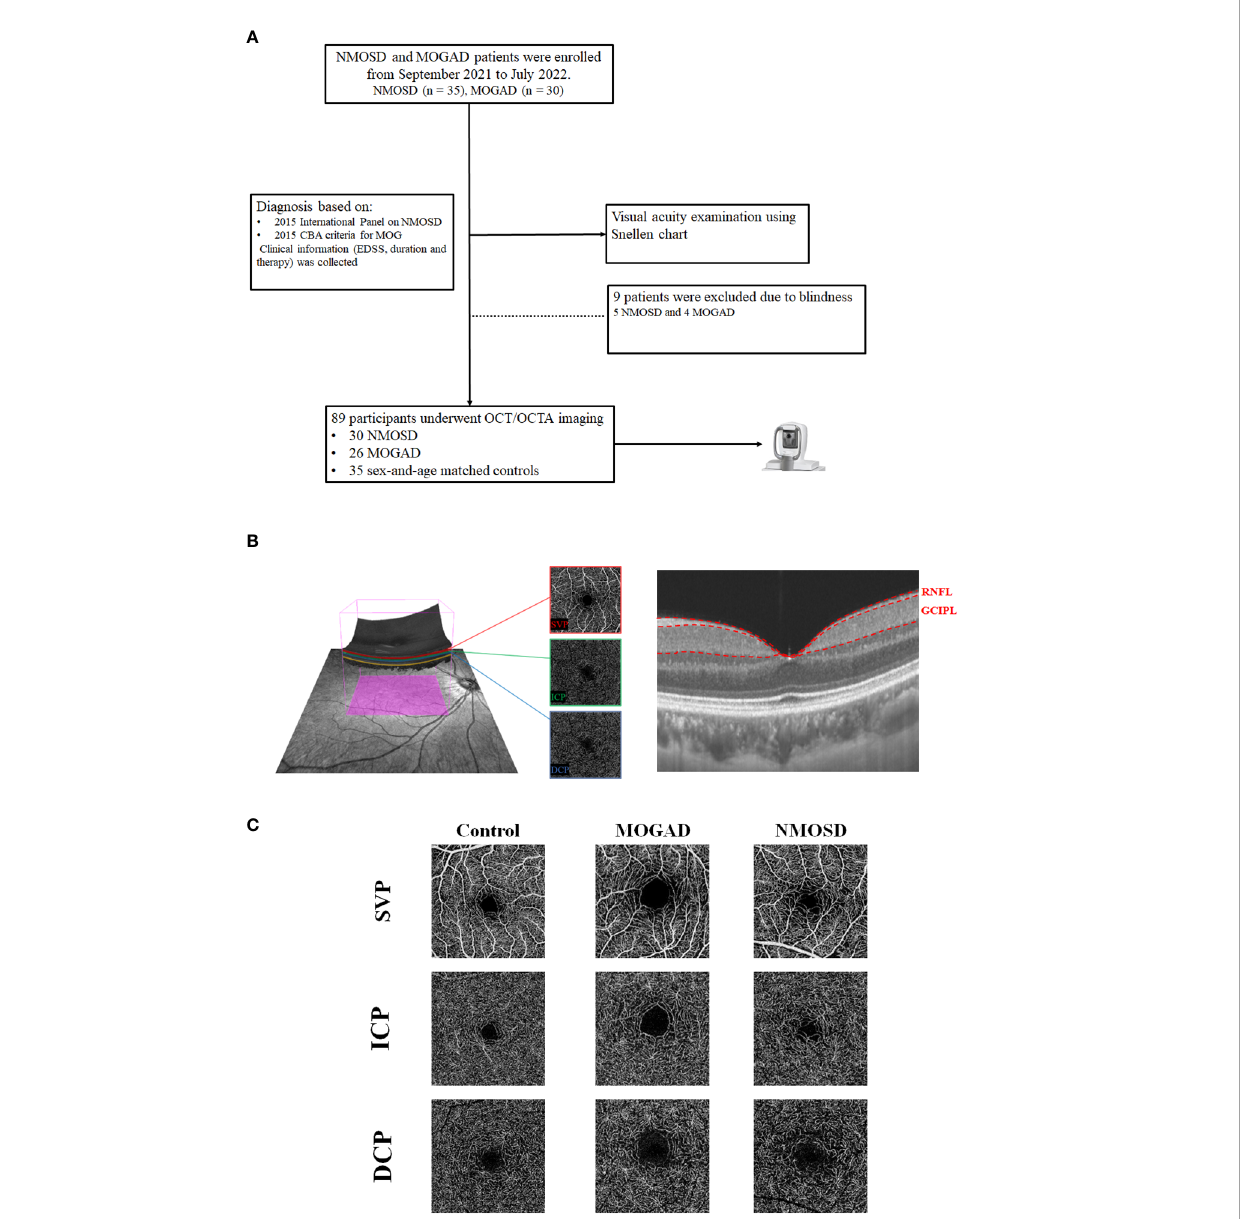
FIGURE 1 The fl owchart of our participants and segmentation of OCT/OCTA images. (A) The fl owchart of the participants in our study. (B) The segmentation of three macular microvascular plexuses and the retinal thickness of RNFL and GCIPL in an area of 3 × 3 mm around the fovea. SVP was de fi ned as the microvasculature between the base of the retinal nerve fi ber layer (RNFL) to the junction between the inner plexiform layer (IPL) and inner nuclear layer (INL); ICP was the microvessels between the IPL/INL junction to the INL/outer plexiform layer (OPL) junction, while DCP was the microvessels between the INL/OPL junction to 25 µm below the OPL. (C) The en face angiograms of our